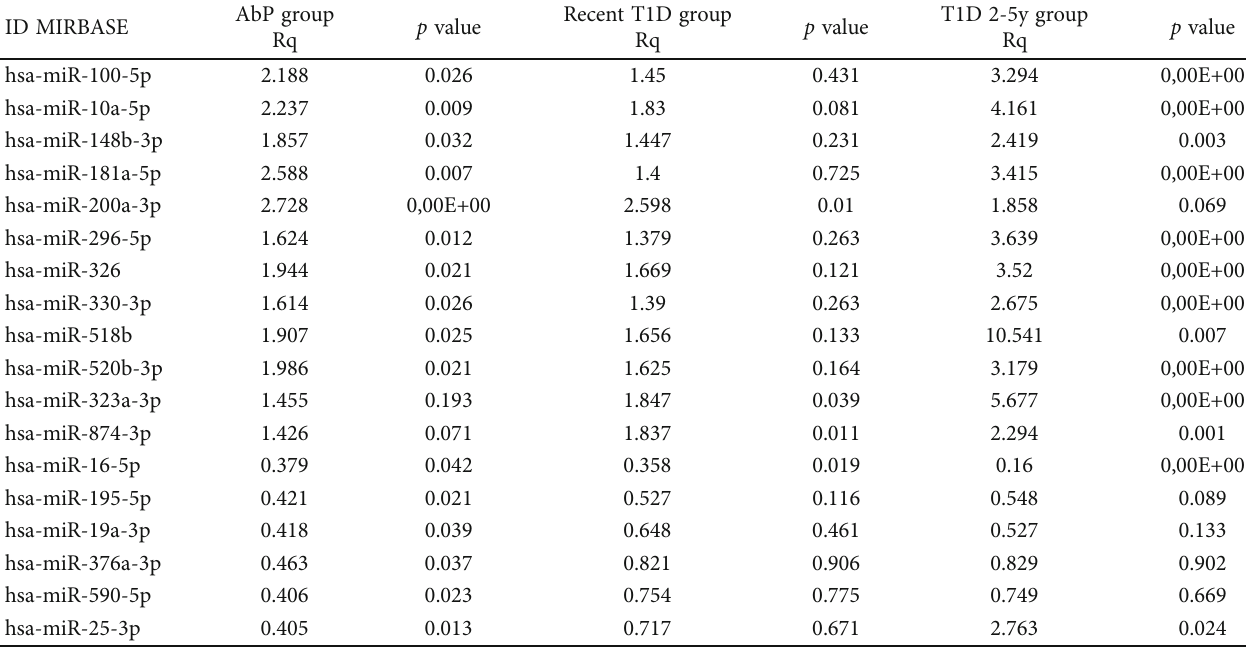
Table 2: MicroRNA expression pro fi le of cluster A in comparison to the control group. ID